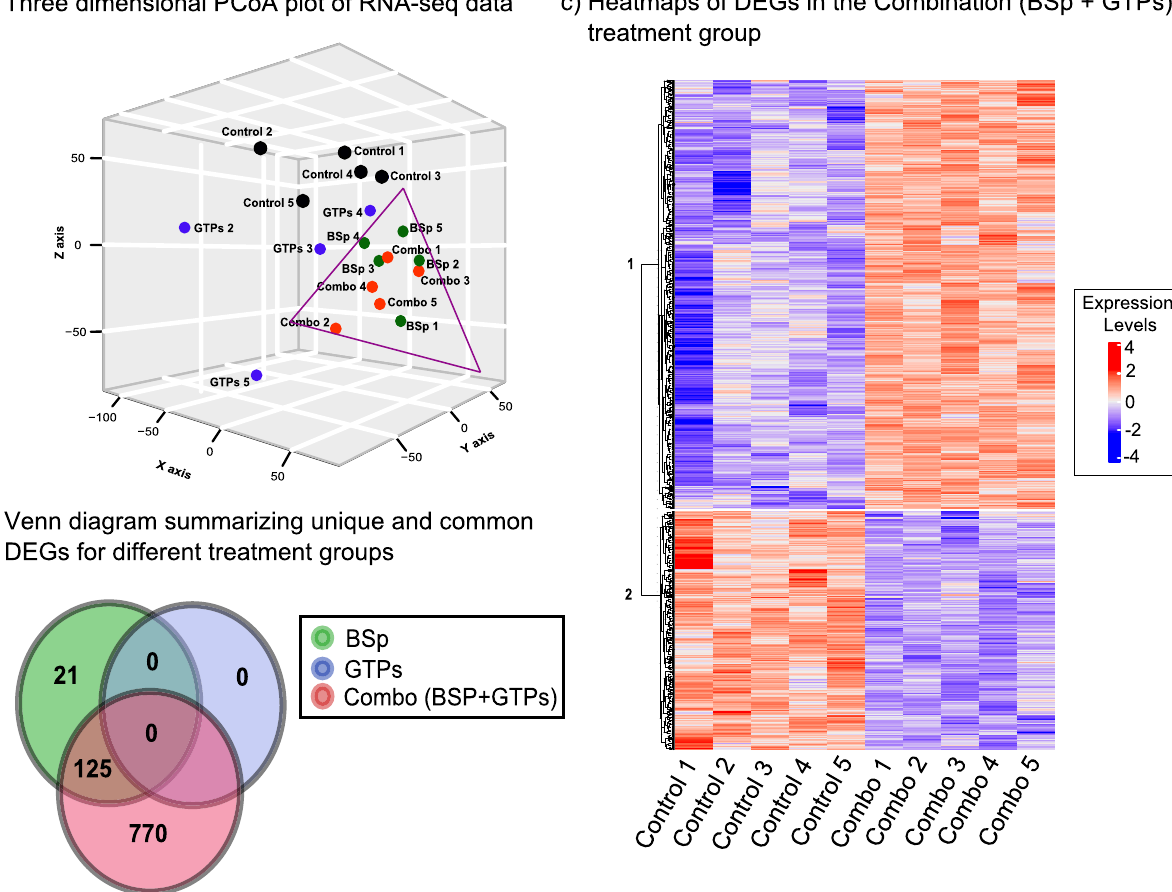
Figure 3. Transcriptome analyses across BSp, GTPs and Combination (BSp + GTPs) treatment groups. ( a ) Three dimensional PCoA plot demonstrating spatial arrangements of different samples. ( b ) Venn diagram summarizing total number of unique and overlapping differentially expressed genes in BSp, GTPs and combination (BSp + GTPs) treatment groups. Green circle represents BSp, Blue color represents GTPs and Red color denotes the combination (BSp + GTPs) treatment group. ( c ) Heatmap representing 895 up-regulated and down-regulated genes in the combination (BSp + GTPs) treatment group based on q value. Each row corresponds to differentially expressed transcripts and each column represents biological replicates in control (N Control = 5) and the combination (N Combination = 5) treatment group. Blue color denotes lower expression levels and red color denotes higher expression